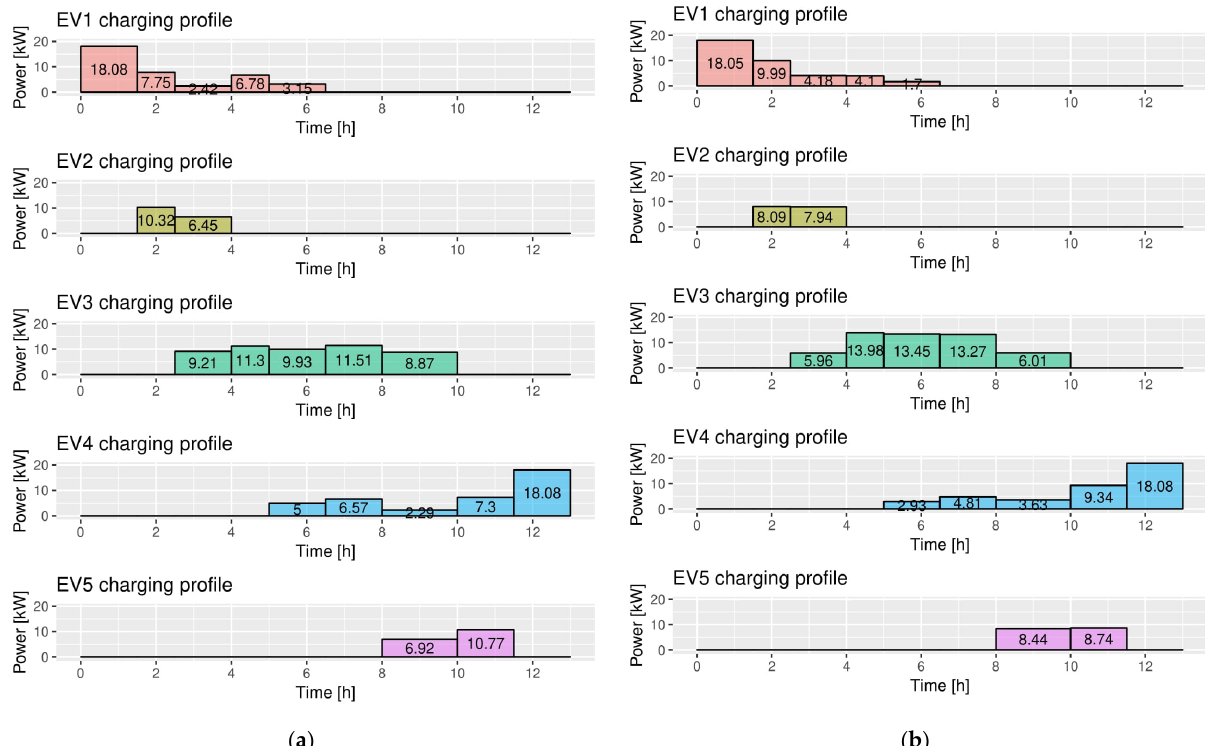
Figure 5. Comparison of EV charging profiles on different stages of algorithm operation. ( a ) Individual EV charging profiles after F β minimization. ( b ) Individual EV charging profiles after F P (profile irregularity) minimization.